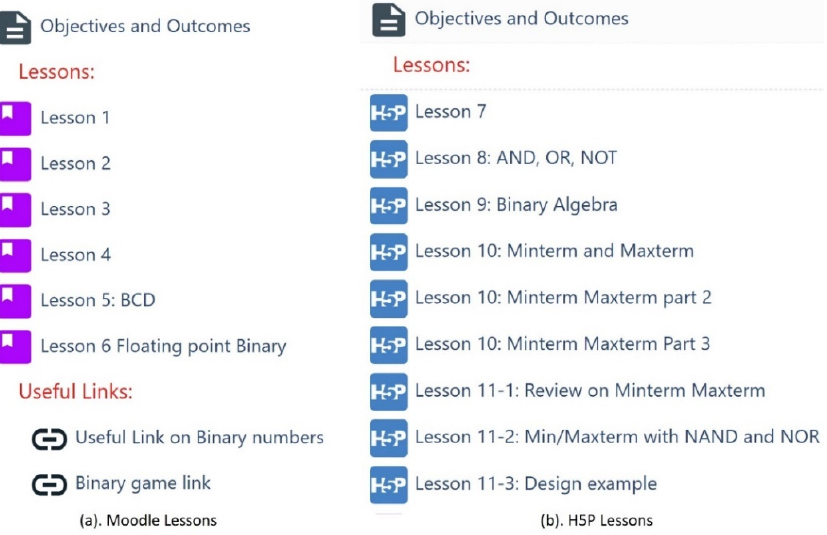
Figure 3. Screenshot of the ( a ) Moodle lessons and ( b ) H5P lessons created for students.